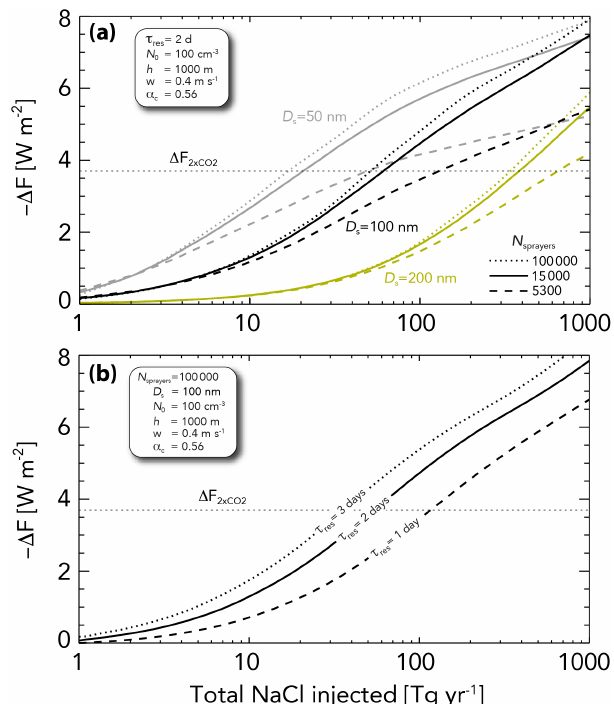
Figure 6. Radiative forcing as a function of the total (global) rate of salt mass injection for (a) three sprayer numbers ( N sprayers = 5300, 15000, and 120000) and for geometric mean spray diameters D s of 50nm (gray), 100nm (black), and 200nm (yellow). (b) Forcing for N sprayers = 120000 and D s = 100nm as a function of injected particle lifetime. All other parameters are the same as those used in Fig.